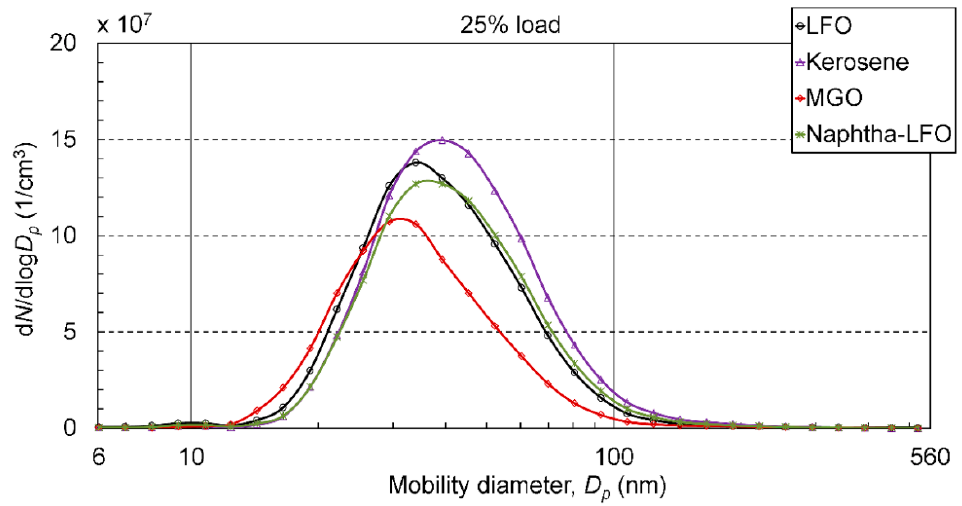
Figure 5. Exhaust PSDs at 25% load.